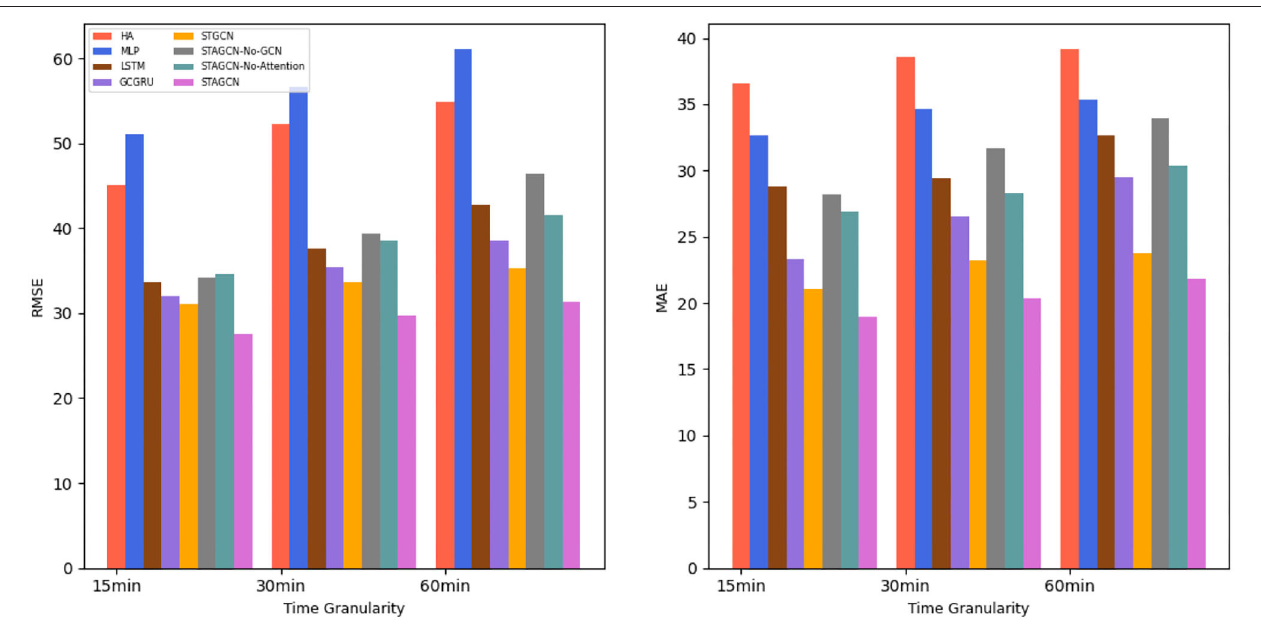
FIGURE 5 | Comparison of average performance of the different methods.